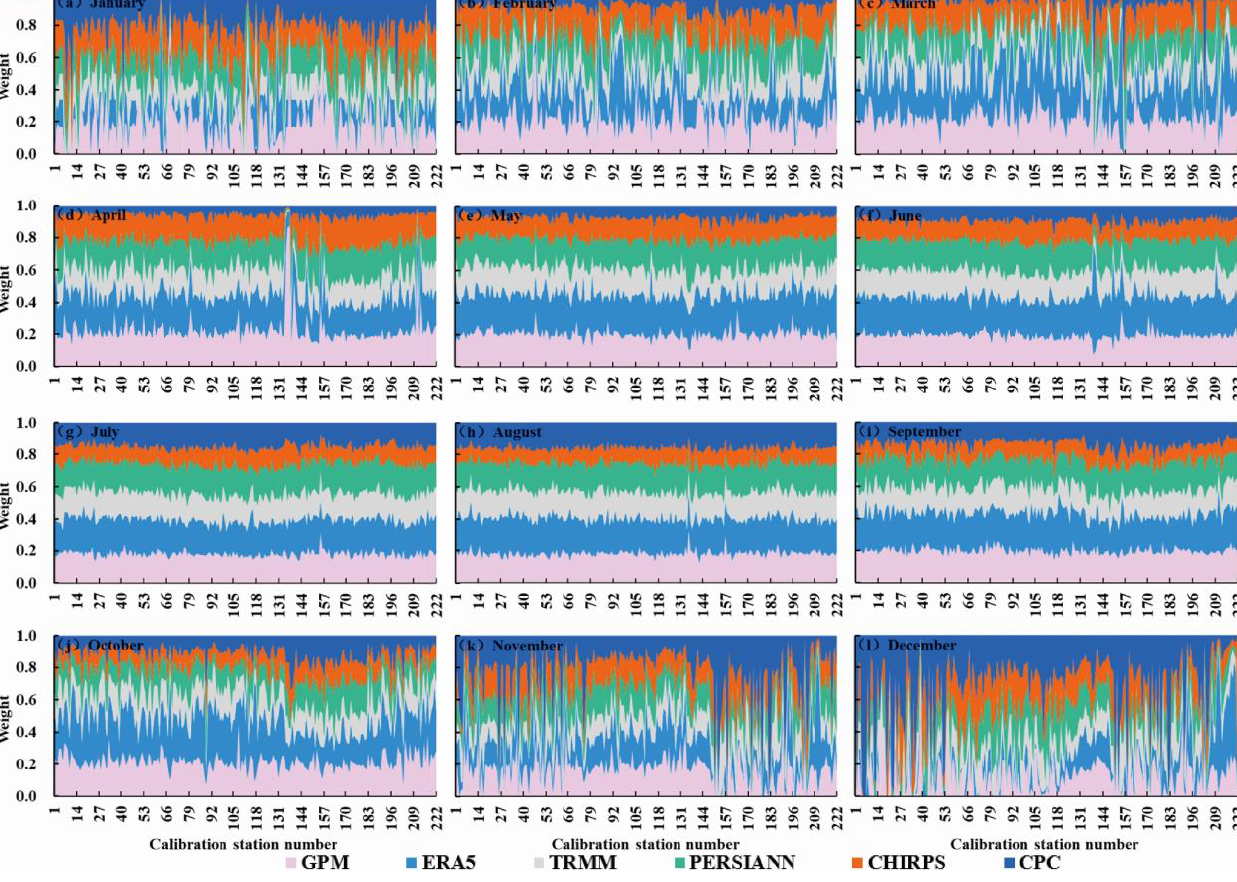
Figure 4. Monthly BMA weights of daily precipitation for calibration stations across the Yellow River basin; 1 to 222 represents the calibratio n station number. ( a ) January; ( b ) February; ( c ) March; ( d ) April; ( e ) May; ( f ) June; ( g ) July; ( h ) August; ( i ) September; ( j ) October; ( k ) November ( l ) Decem- ber.